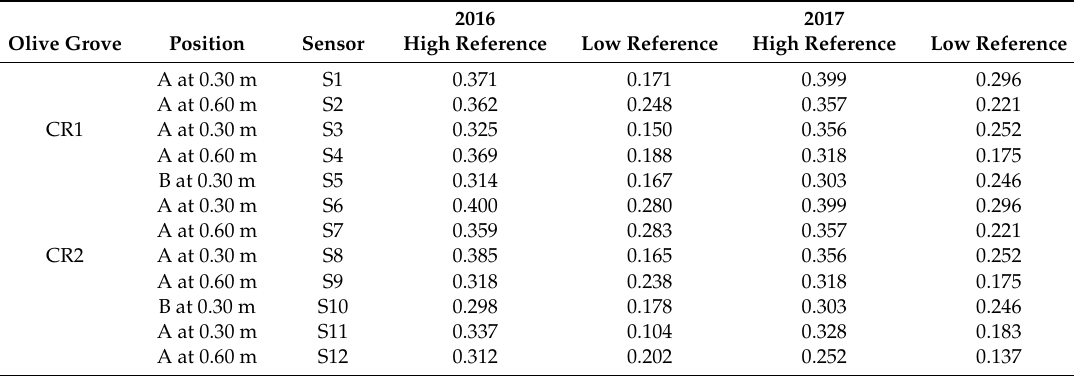
Table 5. High and low reference values of each of the moisture